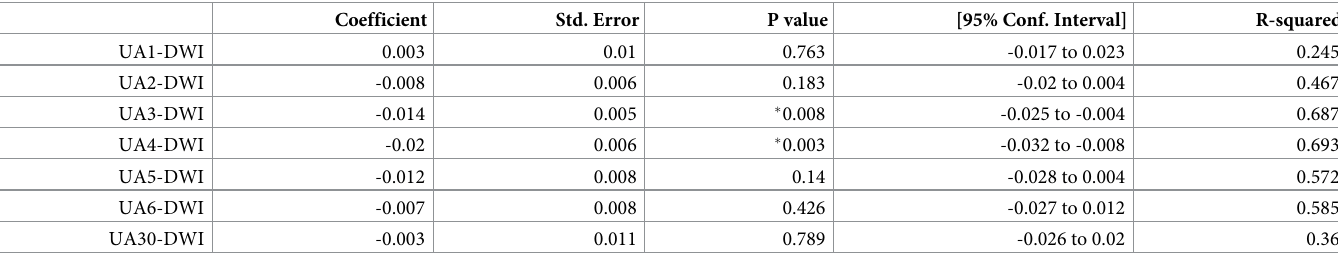
Table 4. Multivariable linear regression of uric acid values during follow up on DWI volumes, adjusted by sex and age. UA = Uric acid, � = significant. Coefficient Std. Error P value [95% Conf. Interval] R-squared 0.003